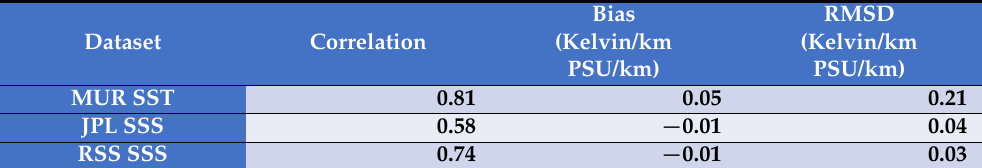
Bias RMSD (Kelvin/km (Kelvin/km PSU/km) PSU/km)